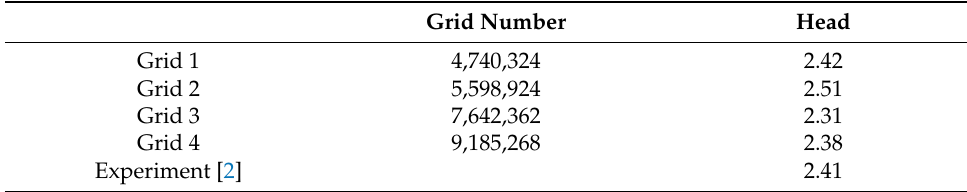
Table 3. Head of the impeller obtained using different number of